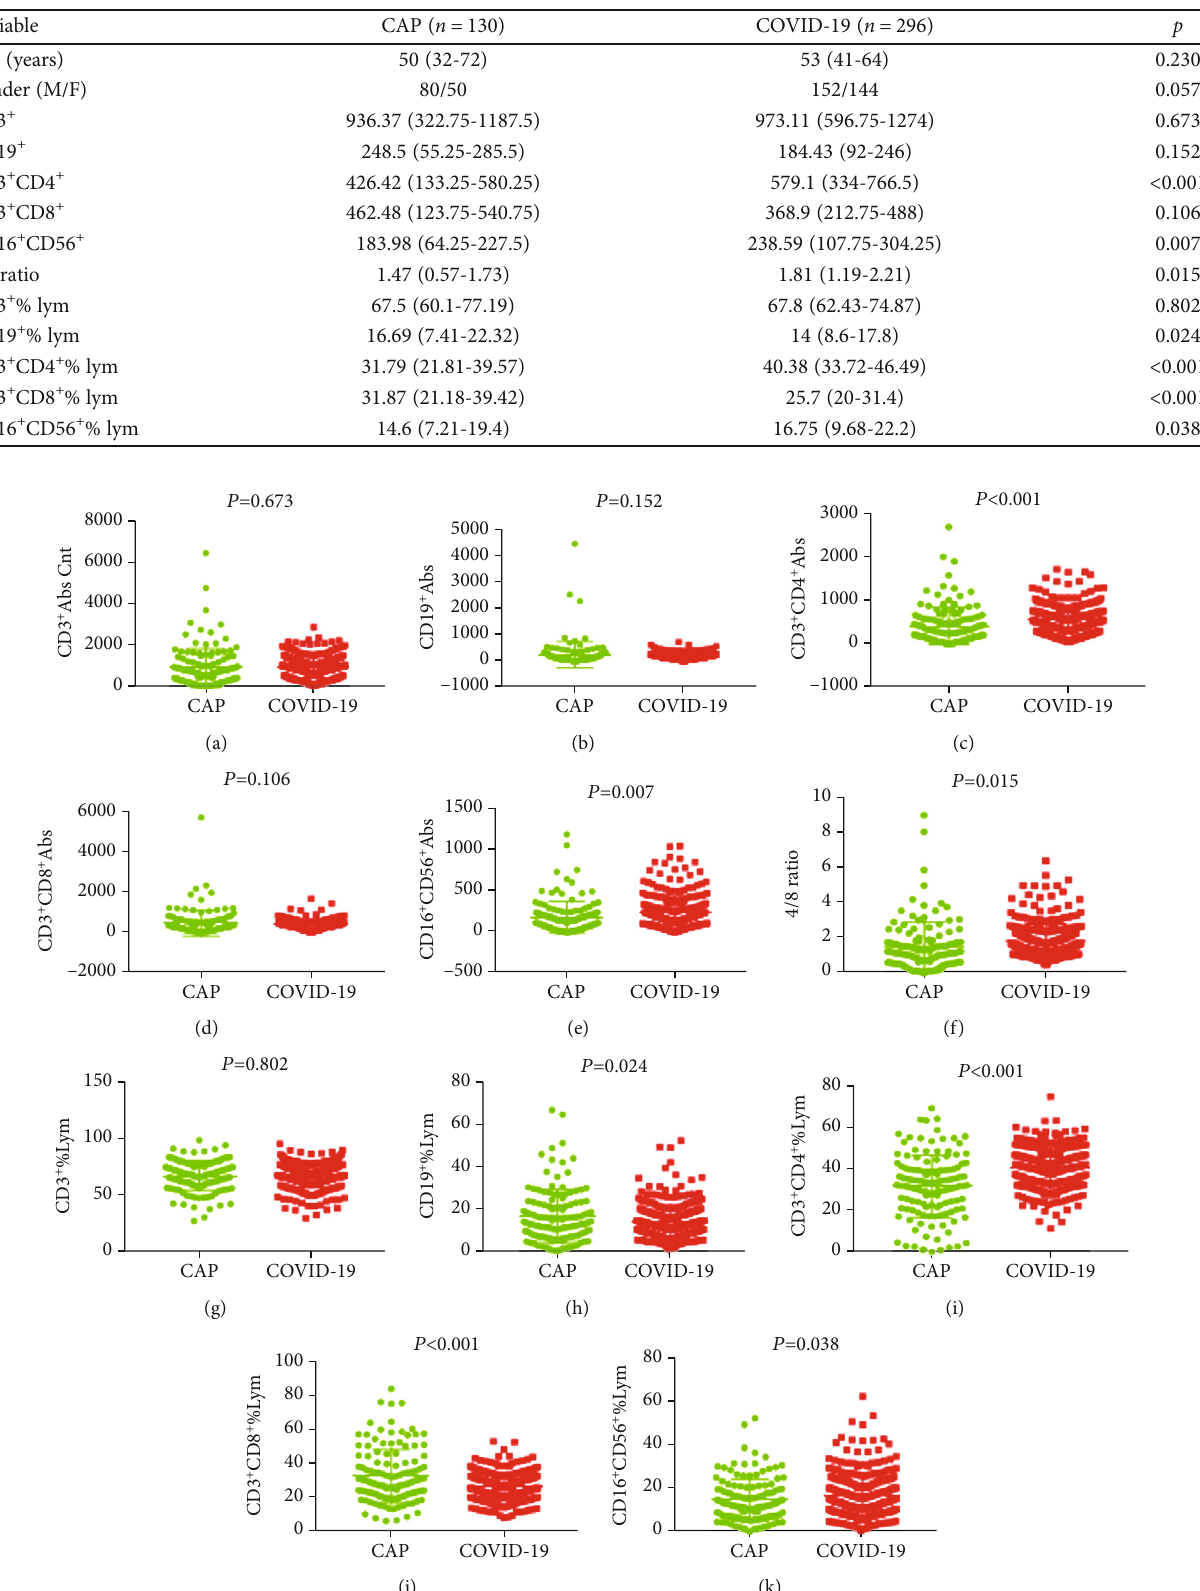
Table 1: Laboratory values of COVID-19 patients and CAP patients.